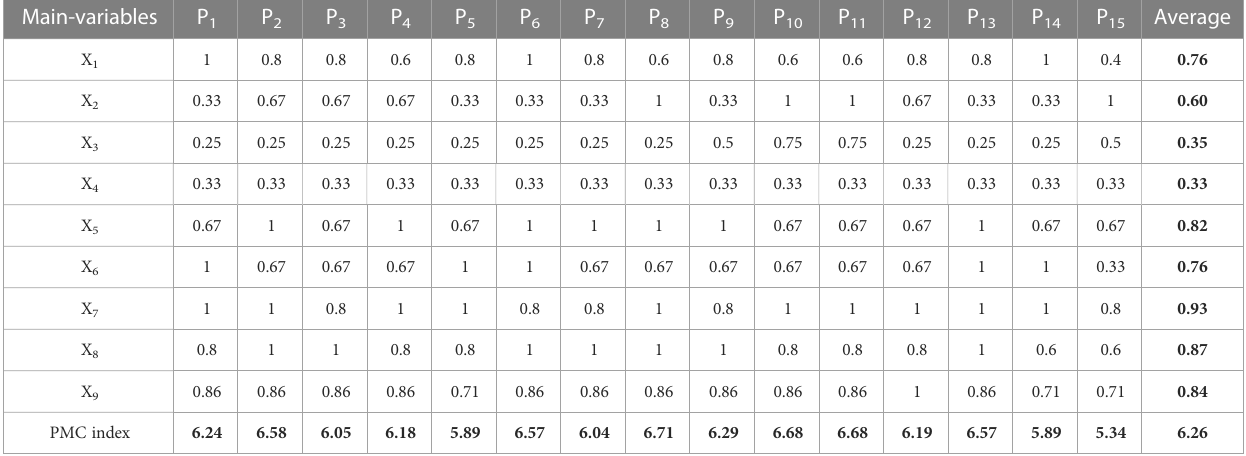
TABLE 4 The PMC index for studied China ’ s shipping decarbonization policies.